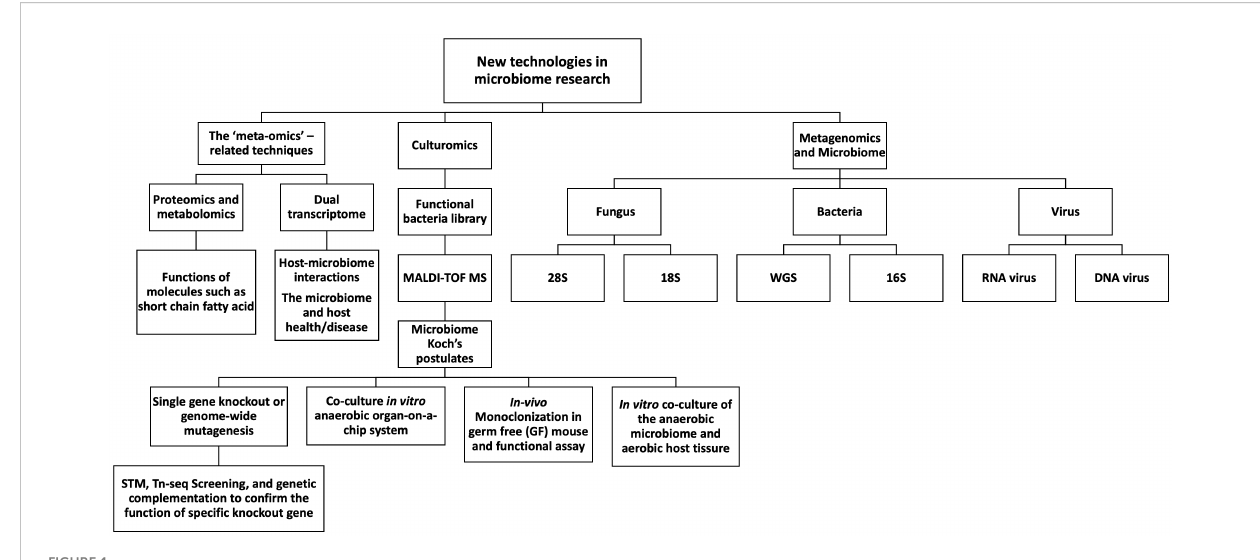
FIGURE 1 New techniques in microbiome